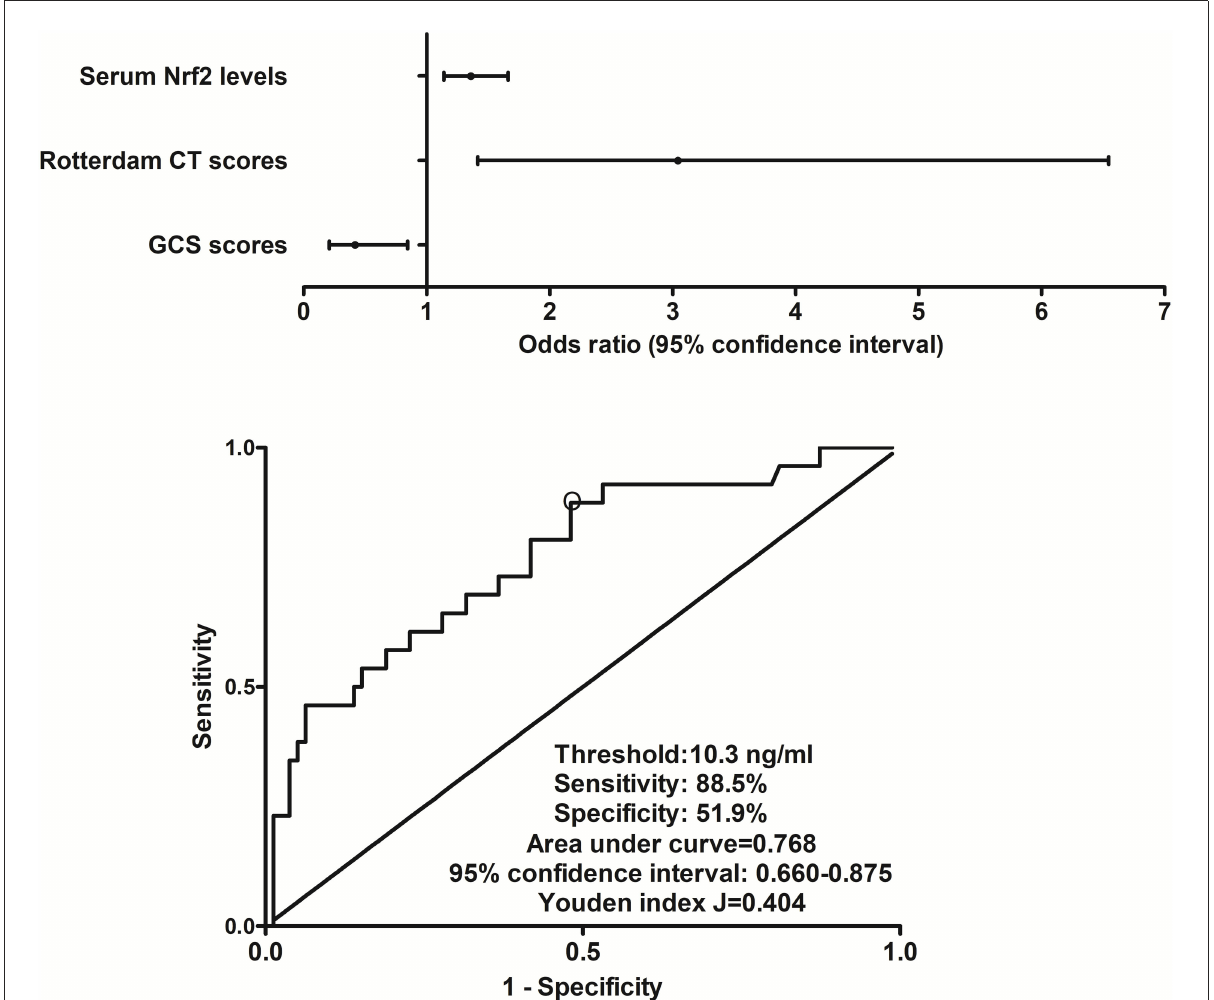
FIGURE4 Relationship between serum nuclear factor erythroid 2-related factor 2 levels and 180-day death after severe traumatic brain injury. Serum nuclear factor erythroid 2-related factor 2 levels, Rotterdam computed tomography scores, and Glasgow Coma Scale scores were the three independent predictors of 180-day death after severe traumatic brain injury (all P < 0.05). Serum nuclear factor erythroid 2-related factor 2 levels were significantly predictive of 180-day death under receiver operating characteristic curve ( P < 0.001), and using Youden’s method, an optimal value of nuclear factor erythroid 2-related factor 2 levels was chosen, which produced medium–high sensitivity and specificity values for death prediction. Nrf2 indicates nuclear factor erythroid 2-related factor 2; CT, computed tomography; GCS, Glasgow Coma Scale.